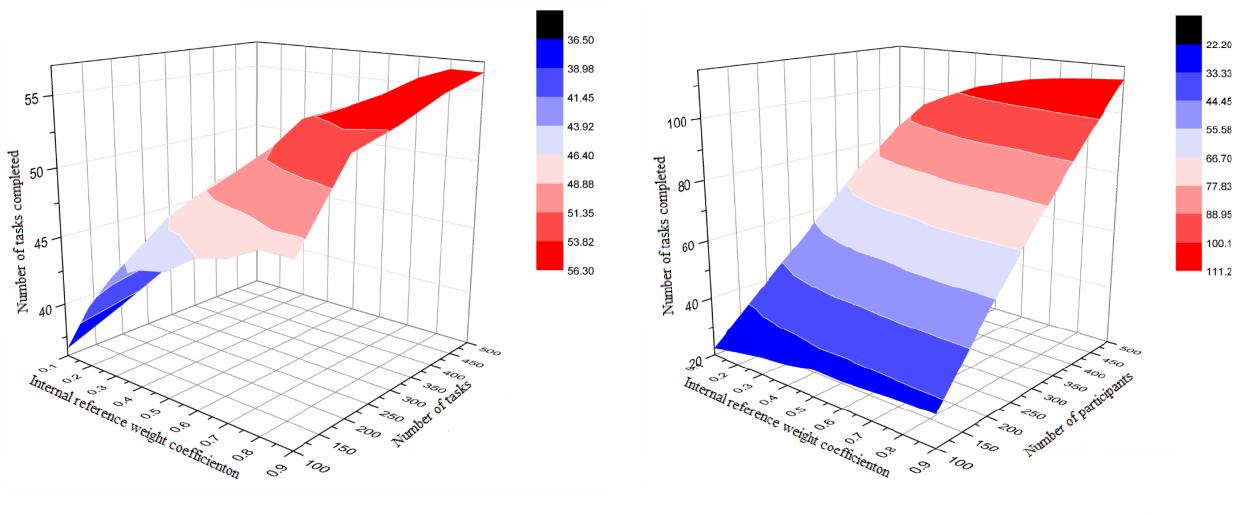
Figure 5. Impact of Internal reference weight factor on the number of tasks completed.